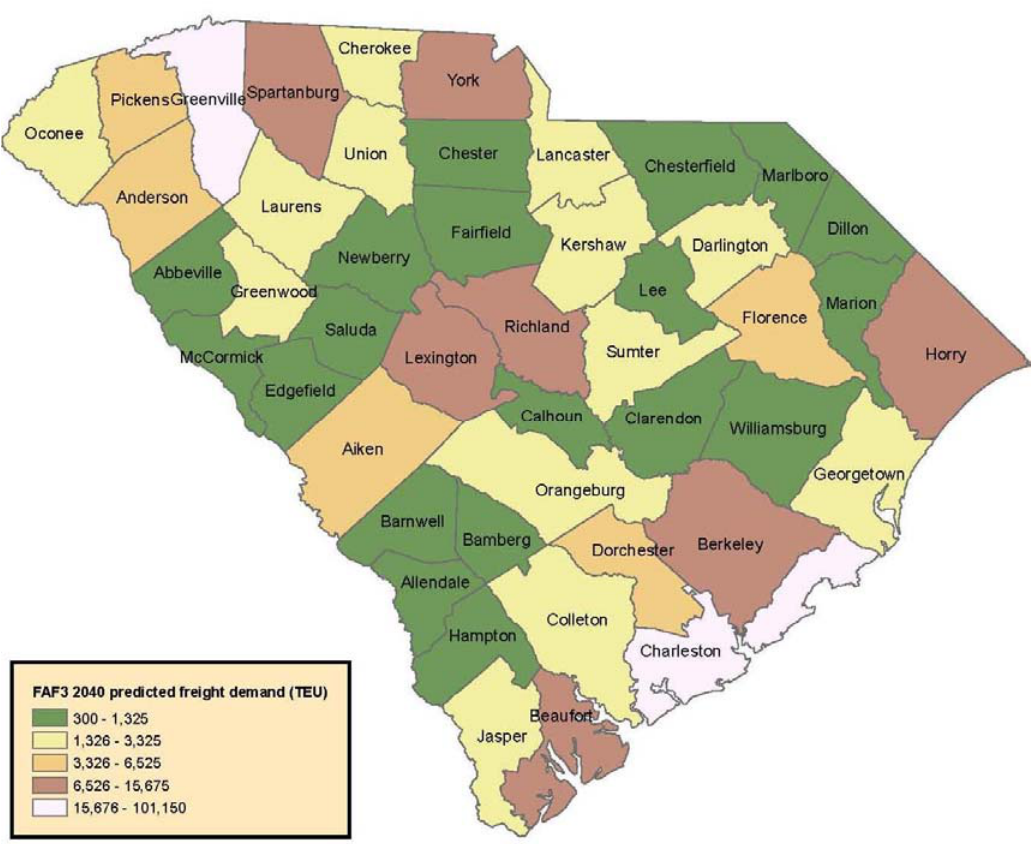
Fig. 3. FAF3 2040 predicted freight demand for SC